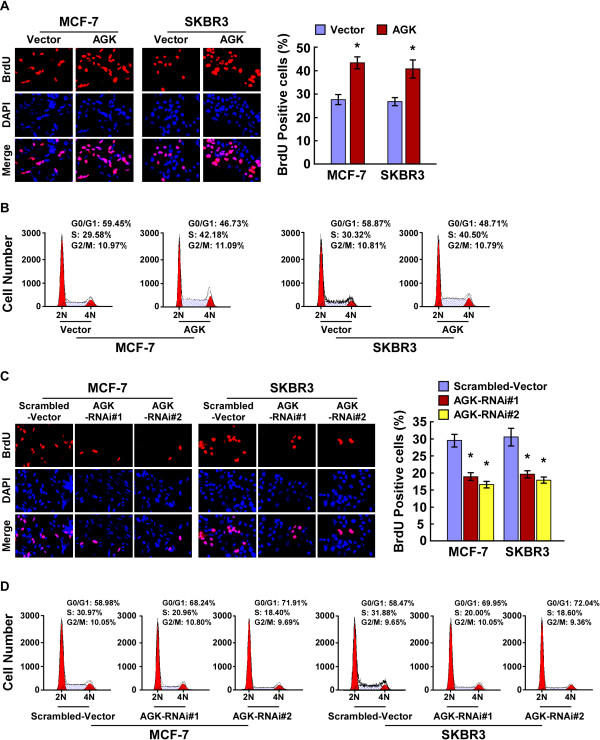
AGK regulates the G1-S phase cell cycle transition in breast cancer cells. (A) Representative micrographs (left) and quantification (right) of BrdU incorporation by the indicated cells. (B) Flow cytometric analysis of vector control and AGK-overexpressing cells. (C) Representative micrographs (left) and quantification (right) of BrdU incorporation by vector and AGK shRNA-infected cells. (D) Flow cytometric analysis of vector and AGK shRNA-infected cells. Each bar represents the mean ± SD of three independent experiments. *P < 0.05.